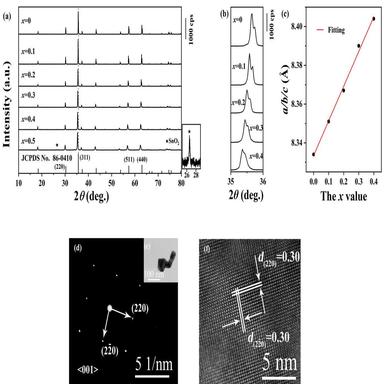
(a) X-ray diffraction patterns, (b) (311) peak position, and (c) lattice parameters of ZGSO:Cr3+ (x = 0-0.5). (d) SAED pattern, (e) TEM image and (f) HRTEM image of ZGSO:Cr3+ (x = 0.4).